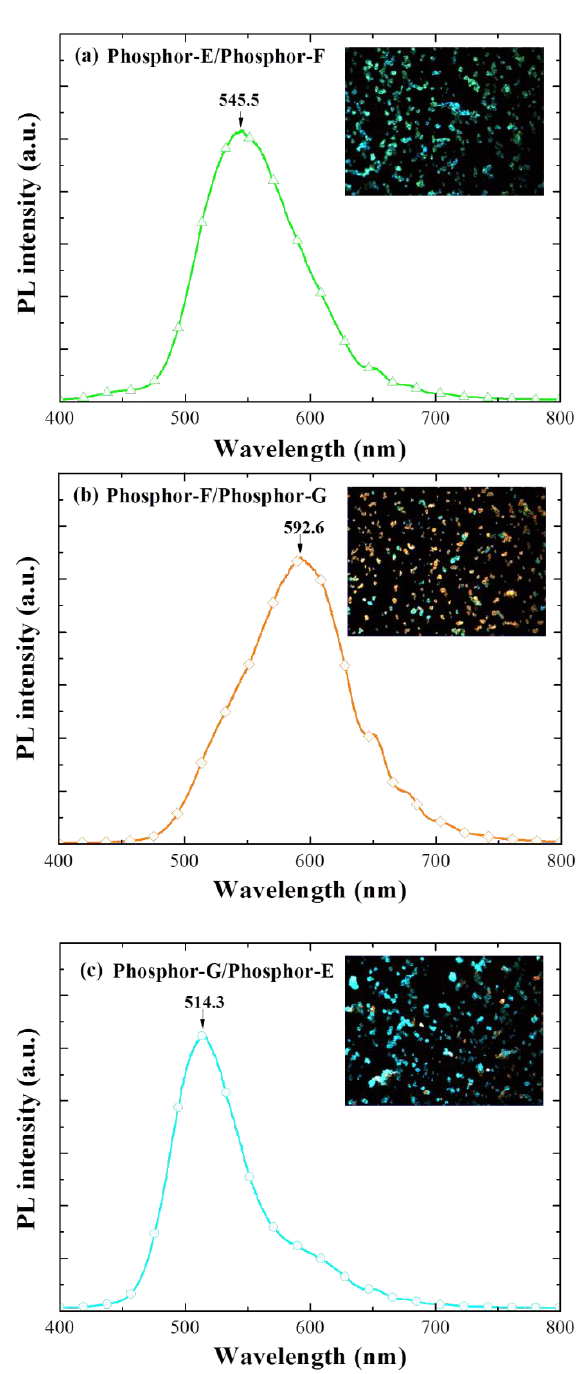
Figure 6. PL spectra of samples with bottom/top LDS layers containing two phosphors: ( a ) E/F; ( b ) F/G; ( c ) G/E.